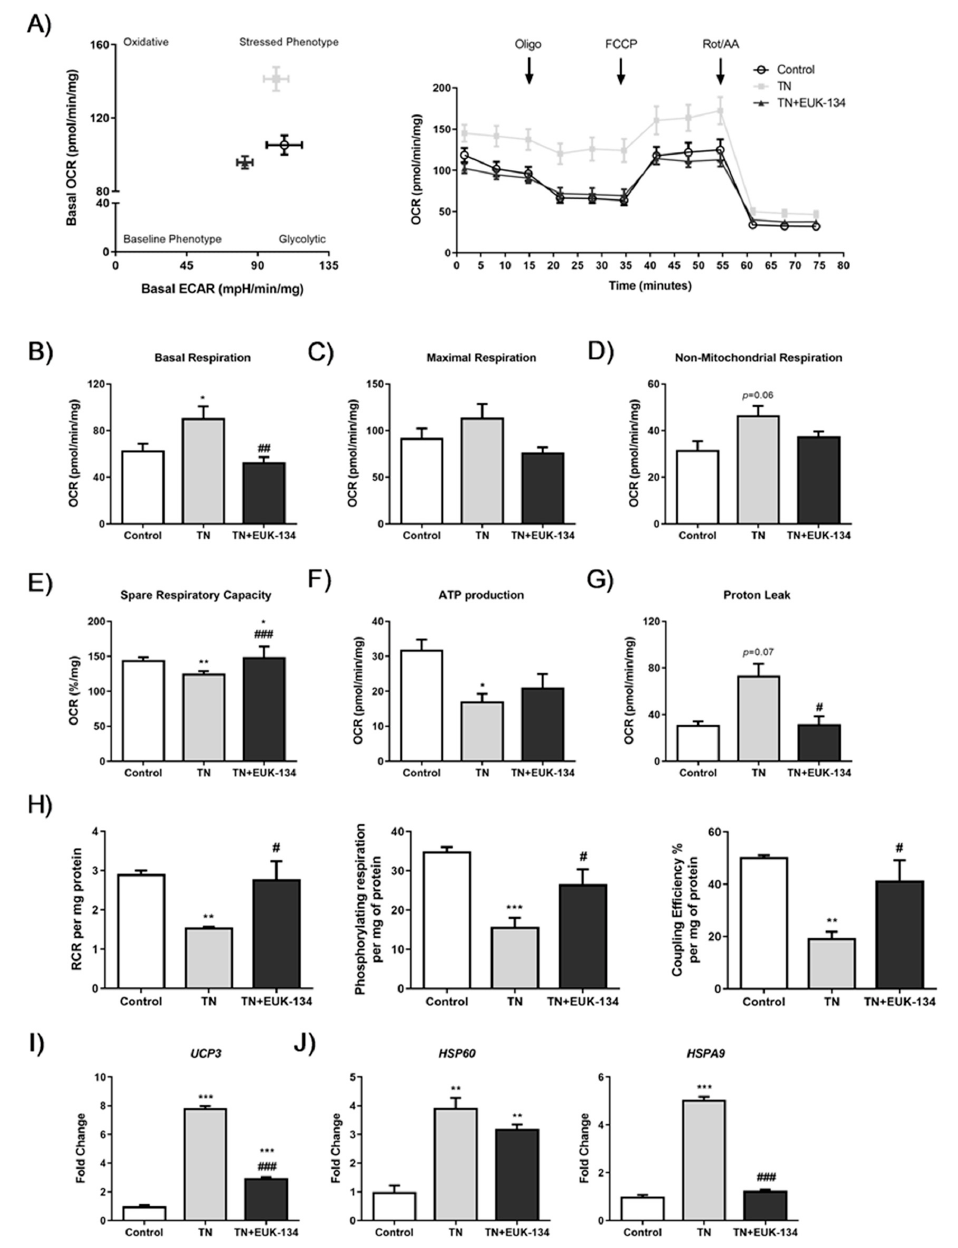
Figure 2. Cellular bioenergetics of tunicamycin-treated cells with or without EUK-134. ( A ) Bioenergetic status presented by basal oxygen consumption rate versus basal extracellular acidification rate, and real-time oxygen consumption rate measured under basal conditions followed by the sequential addition of oligomycin, FCCP, and rotenone / antimycin A mix. ( B – G ) Individual parameters of mitochondrial function; basal respiration, maximal respiration, non-mitochondrial respiration, spare respiratory capacity, ATP production, and proton leak, normalised to protein content. ( H ) Normalised respiratory flux control ratios, respiratory control ratio, phosphorylating respiration, and coupling e ffi ciency (%), derived from the individual mitochondrial parameters. Data represent the mean ± SEM ( n = 5). * p ≤ 0.033, ** p < 0.002, and *** p < 0.001 against vehicle control or tunicamycin alone (#). ( I ) Relative fold change in mRNA expression of UCP3 . ( J ) Relative fold changes in mRNA expression of mitochondrial unfolded protein response markers, HSP60 and HSPA9 . Data represent the mean fold change normalised to 18S housekeeper gene ± SEM of ∆ Ct values, ( n = 3). * p ≤ 0.033, ** p < 0.002, and *** p < 0.001 against vehicle control or tunicamycin alone (#). OCR, oxygen consumption rate; ECAR, extracellular acidification rate; RCR, respiratory control